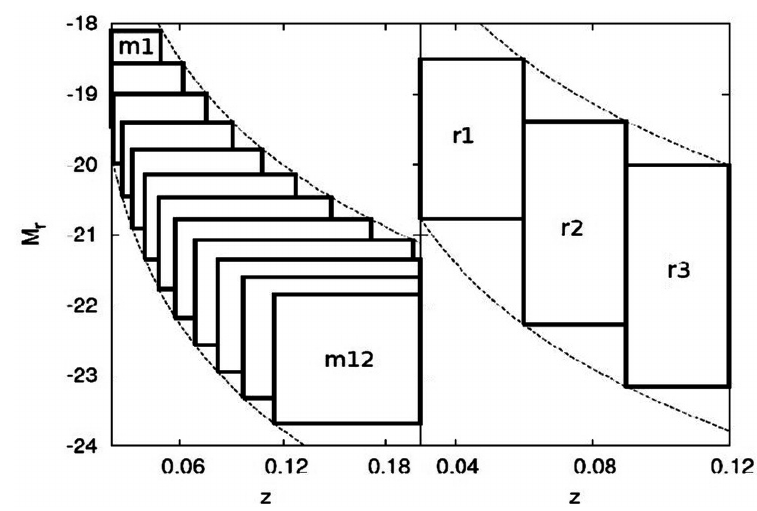
Fig. 1. Magnitude and redshift boundaries of the 12 (left panel) and 3 (right panel) volume-limited galaxy samples for a large coverage in depth ( m samples) and magnitude ( r samples),